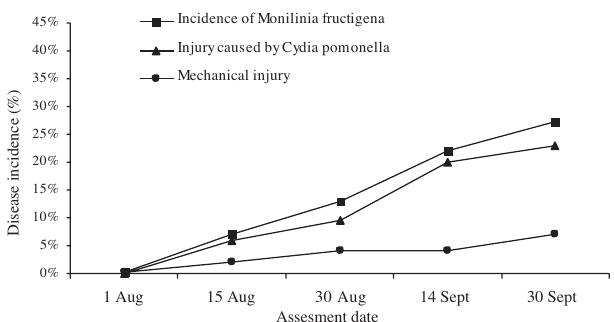
Figure 1. Disease incidence of Monilinia fructigena, incidence of Cydia pomonella damage and of mechanical injury on fruit in an organic apple orchard (Eperjeske, 2011).